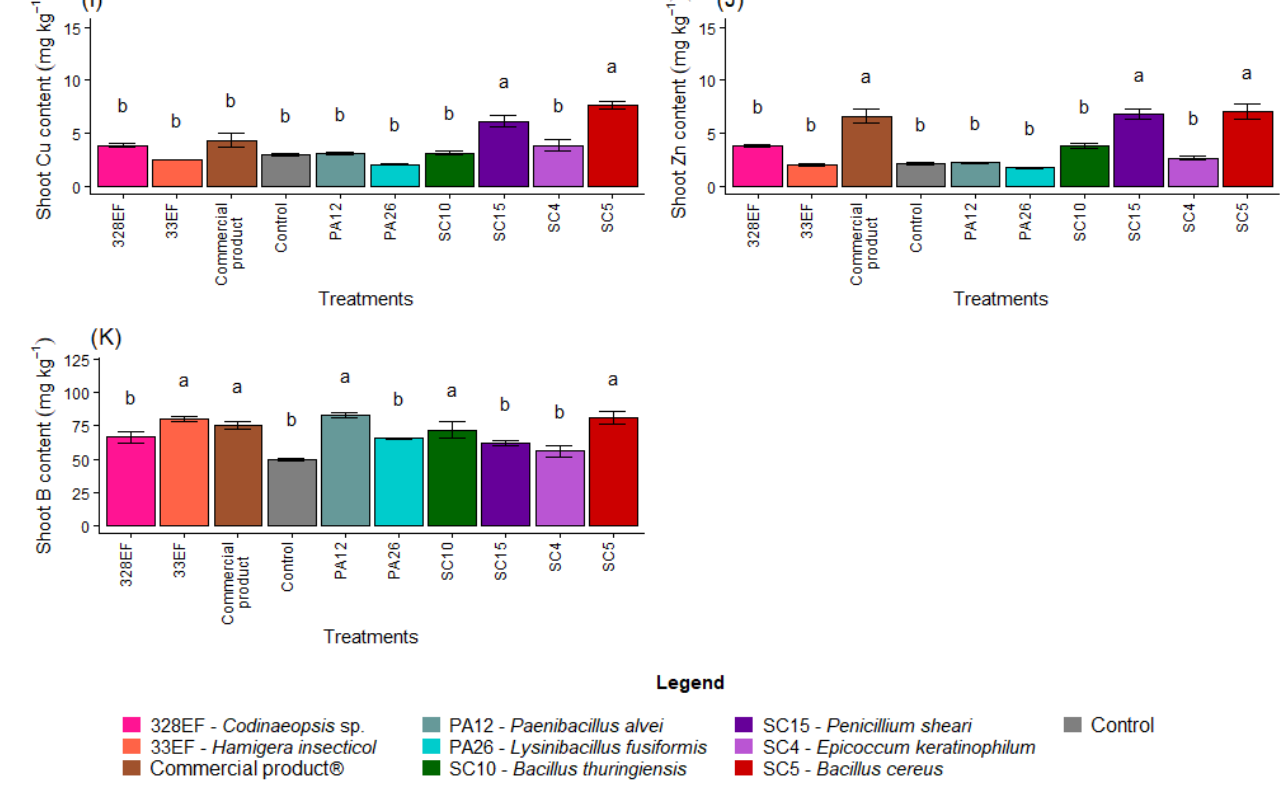
Figure 2. Content of the macronutrients N ( A ), P ( B ), K, ( C ), Ca ( D ), Mg ( E ), and S ( F ) and of the micronutrients Fe ( G ), Mn ( H ), Cu, ( I ), Zn ( J ), and B ( K ) in the aerial part of soybean ( Glycine max) plants inoculated with fungal and bacterial strains isolated from Hymenaea courbaril and Butia purpurascens and grown in a controlled greenhouse system. Means followed by the same letter were not significantly different using the Scott – Knott test at 0.05% probability.